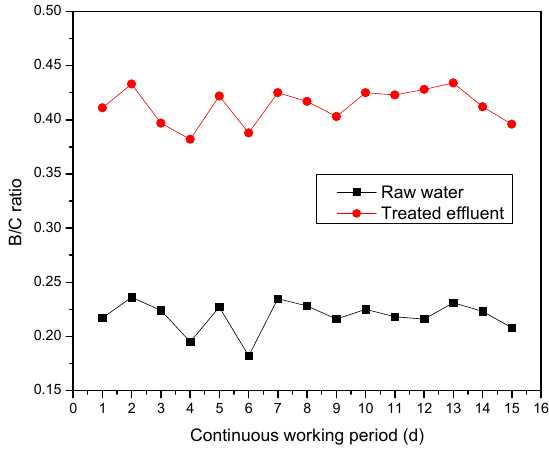
Figure 10. Comparison of B/C ratios before and after micro-electrolysis treatment.